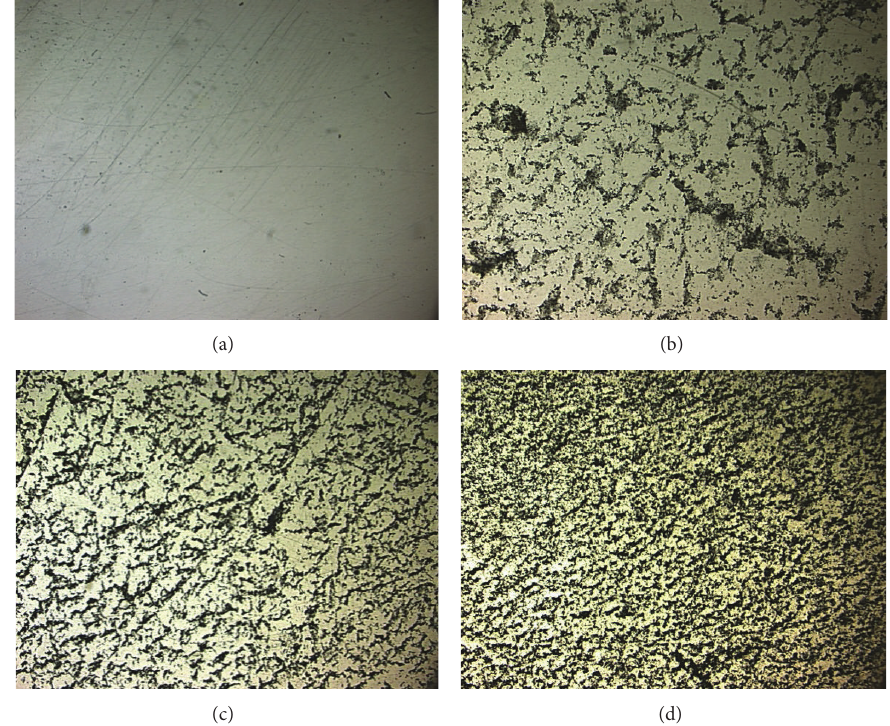
Figure 6: Images of films from gelatin/glycerol and carbon nanotubes. (a) GG and (b) GGNTC1; (c) GGNTC2 and (d) GGNTC4.